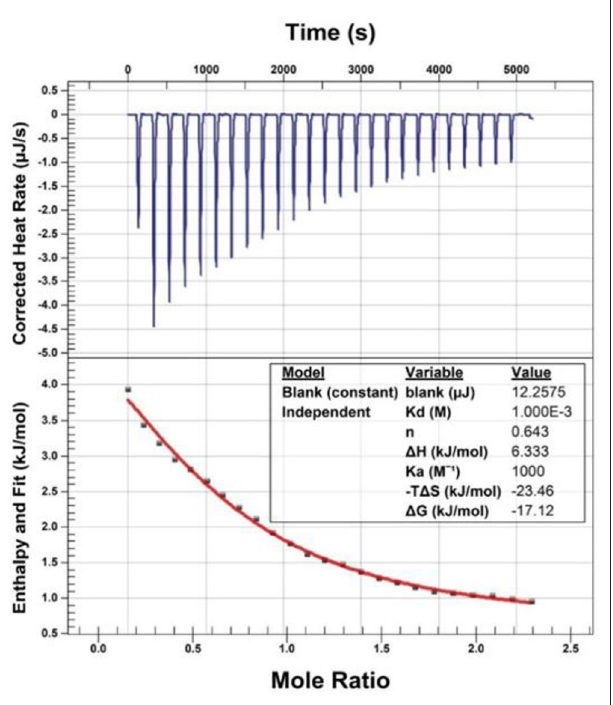
FIGURE 1 | Isothermal titration calorimetry (ITC)